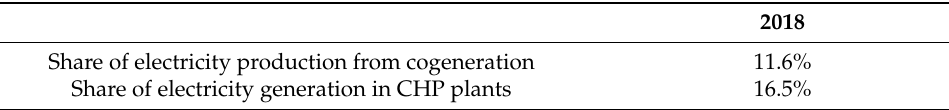
Table 3. Percentage share of gross electricity production and gross cogeneration in Poland’s electric- ity